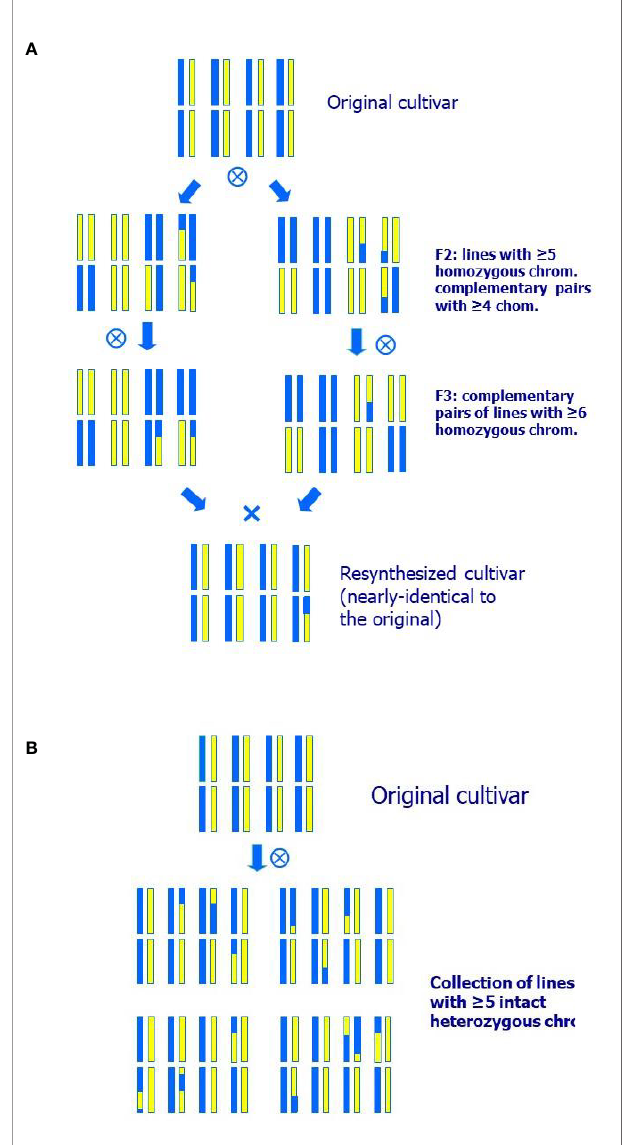
FIGURE 1 | Breeding schemes for a species of eight pairs of chromosomes of: (A) Resynthesis A, where two nearly homozygous and complementary lines are selected to obtain an individual highly similar to the original cultivar; (B) Resynthesis B, generation of a collection of individuals nearly identical to a peach cultivar, but with a small number of chromosomal segments in homozygosis. All individuals of the collection presented have fi ve heterozygous chromosomes as in the original cultivar and only three homozygous fragments